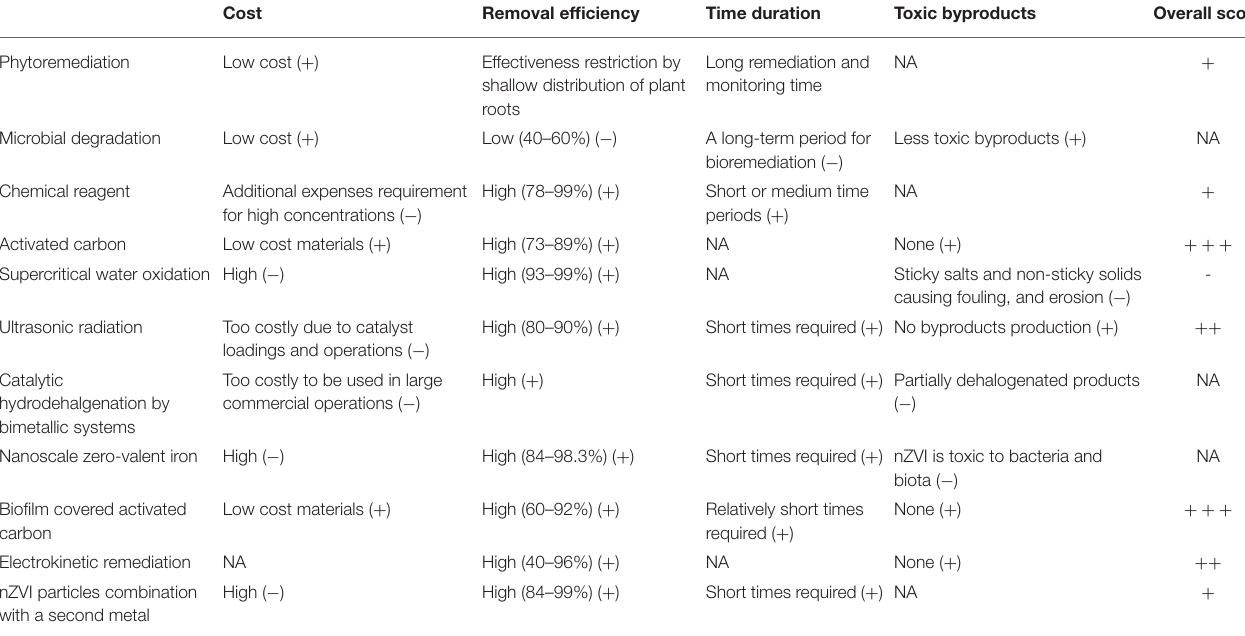
TABLE 3 | Matrix of criteria for different PCB remediation